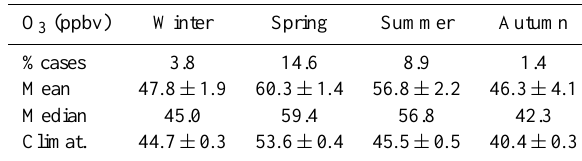
Table 3. Basic statistics of surface O 3 at IZO for days with daily 7 Be > 8mBqm − 3 . The term “climat.” refers to the O considering all the ozone values within the indicated period inde- pendently of the 7 Be